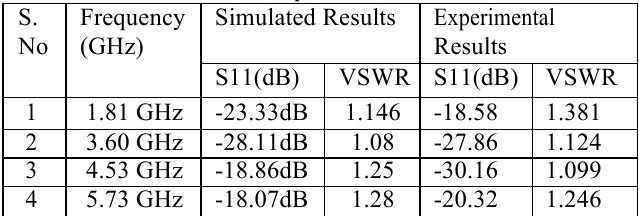
Fabricated antenna using VNA Figure 6.(b): VSWR Experimental result of the fabricated antenna using VNA Comparison of simulated results and Experimental results Table 4. Simulated results and Experimental results